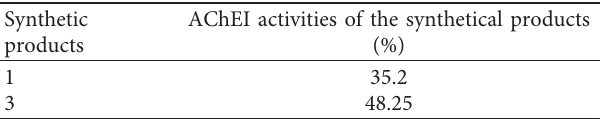
Table 3: Acetylcholinesterase (AChE) inhibitor (AChEI) activities of the synthetic products.